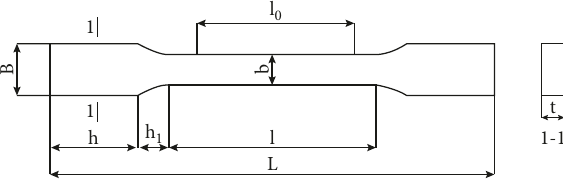
Figure 6: Dumbbell-shaped specimen shape.